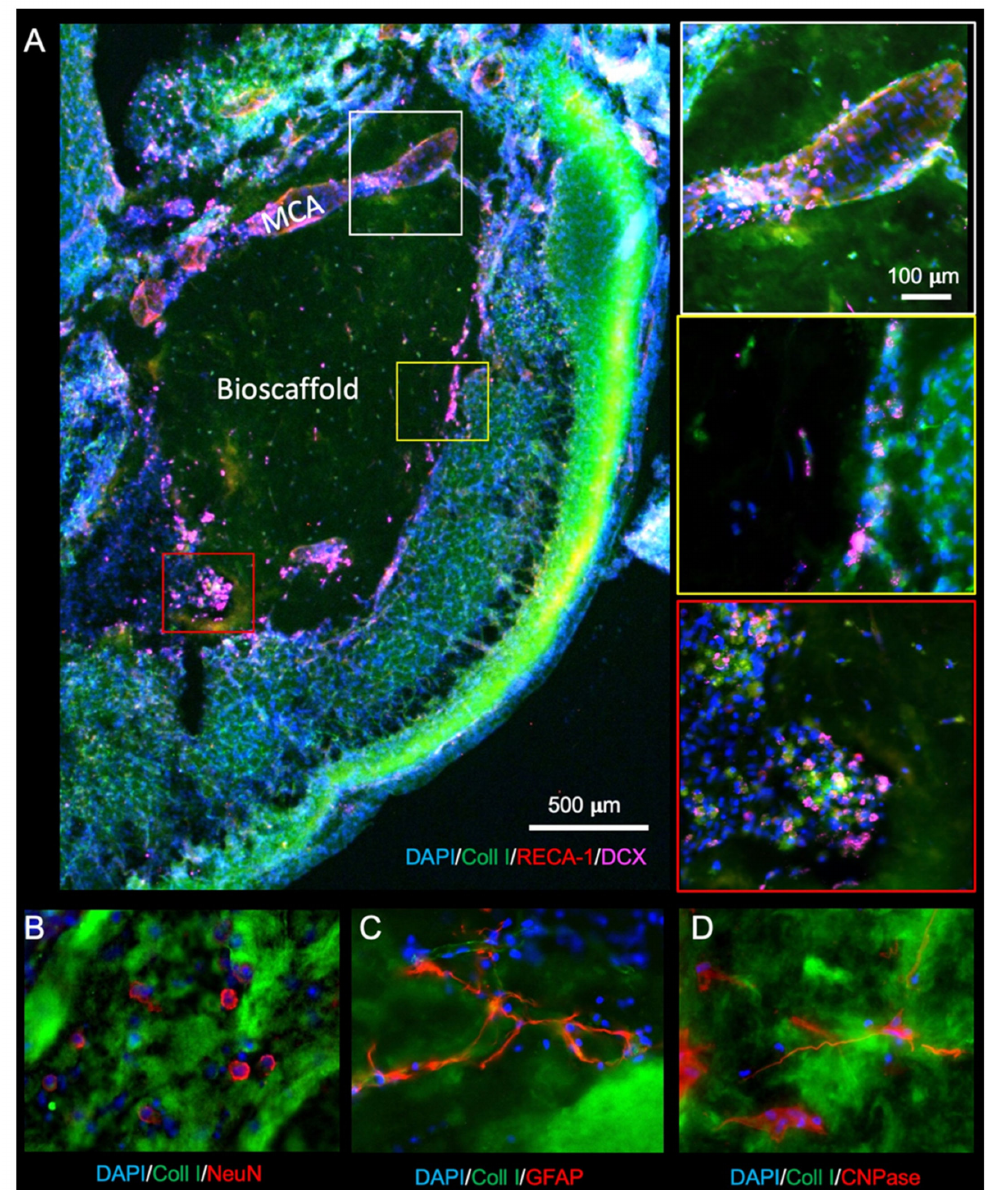
Figure 8. Neuronal and glial cell invasion into the ECM hydrogel. ( A ) Neural progenitor cells (doublecortin, DCX) are observed infiltrating the biomaterial (28-days post-stroke) along the middle cerebral artery (MCA), as well as in groups at the edge of the material. ( B ) To determine whether mature neurons were differentiating in de novo tissue, NeuN staining was performed to target post-mitotic neurons. ( C ) Astrocytes (GFAP+ cells), which form the glial scar surrounding the damaged tissue, presented with long processes extending through the ECM hydrogel. ( D ) Oligodendrocytes (CNPase) also infiltrated the bioscaffolds in the 14- and 28-day post-stroke conditions but less so 90-days